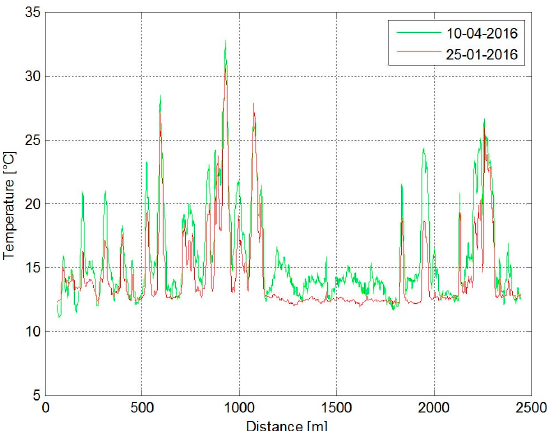
Figure 6. Distributed temperature sensing (DTS) profiles of the off-shore caldera measured by the optical fiber system during 15 January 2016 and 28 April 2016 along a roughly N-S direction. The differences in temperature between the two profiles, above the instrumental error (±1 °C), can be correlated to the temporal variation of heat discharge, which is generally recorded in the onshore area (e.g., Solfatara-Pisciarelli geothermal system).